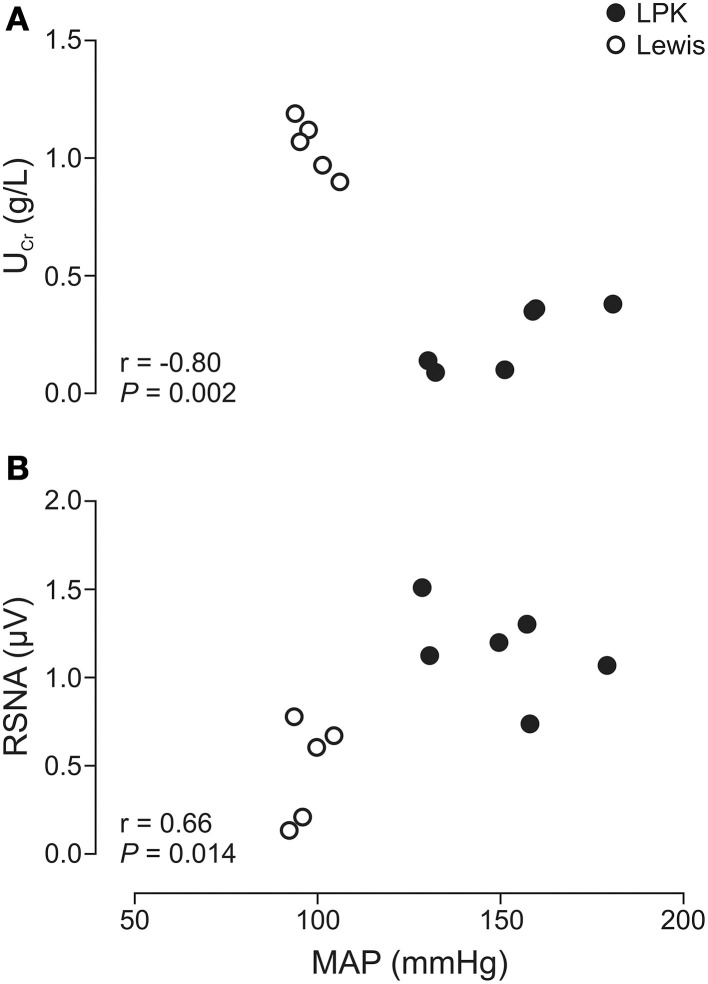
Correlations of mean arterial pressure (MAP) vs. (A) urinary creatinine (UCr) and (B) renal sympathetic nerve activity (RSNA), in Lewis and Lewis Polycystic Kidney (LPK) rats derived from multiple linear regression (n = 11). Pearson correlation coefficient (r) and significance are provided for each relationship within the figure panel.